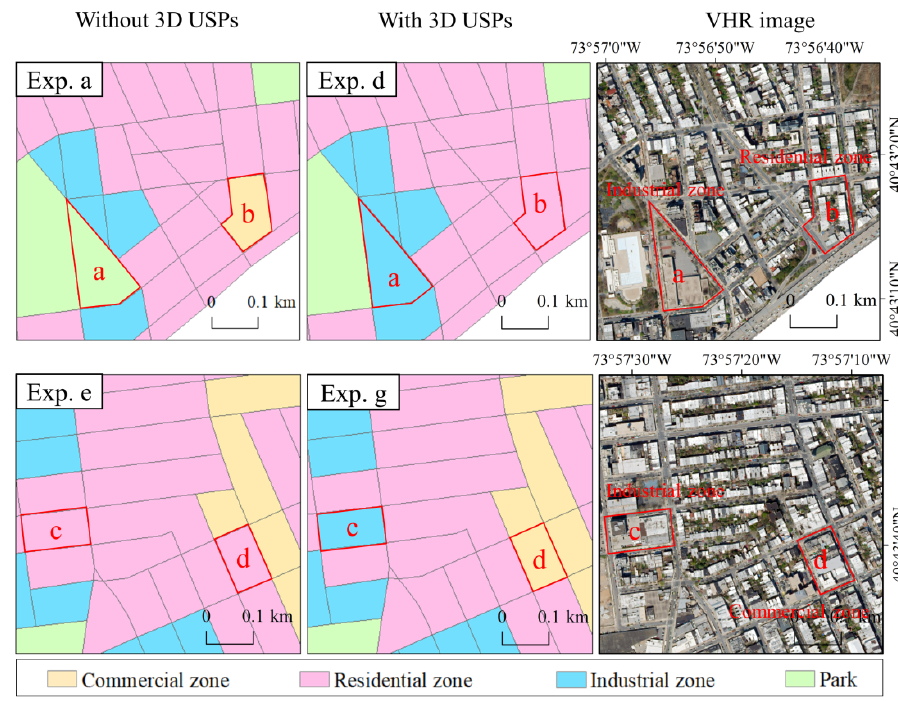
Figure 13. Comparisons of the UFZ classification results of different experiments. Exps. a and e are the UFZ classification results without 3D USPs, Exps. d and g are the UFZ classification results with 3D USPs.